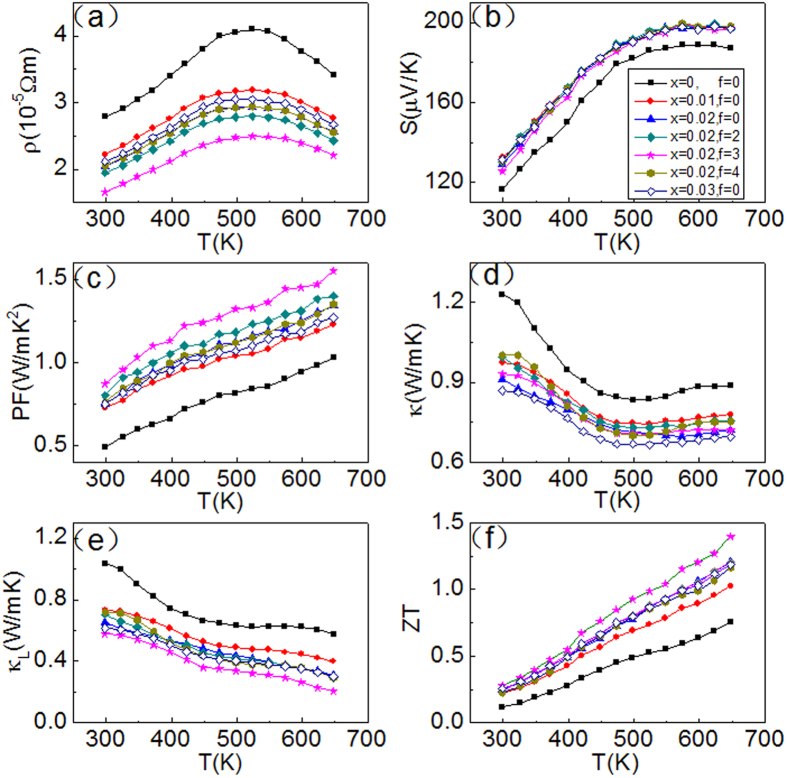
Temperature dependences of (a) electrical resistivity, (b) thermopower, (c) power factor, (d) total thermal conductivity, (e) lattice thermal conductivity, and (f) figure of merit ZT of β-Zn4Sb3, β-(Zn1-xPbx)4Sb3 (x = 0.01, 0.02, and 0.03) and f(Cu3SbSe4)/β-Pb0.02Zn3.98Sb3 (f = 2, 3 and 4vol.%) composite samples.